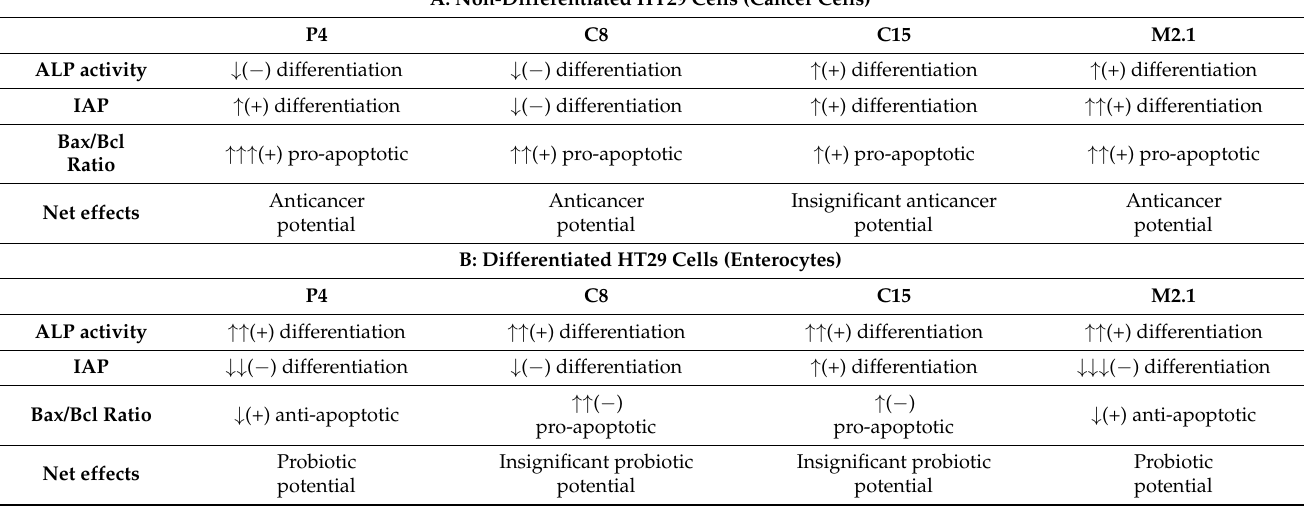
Table 3. Summarized net effects profile of SNs from P4, C8, C15 and M2.1 LAB stains on